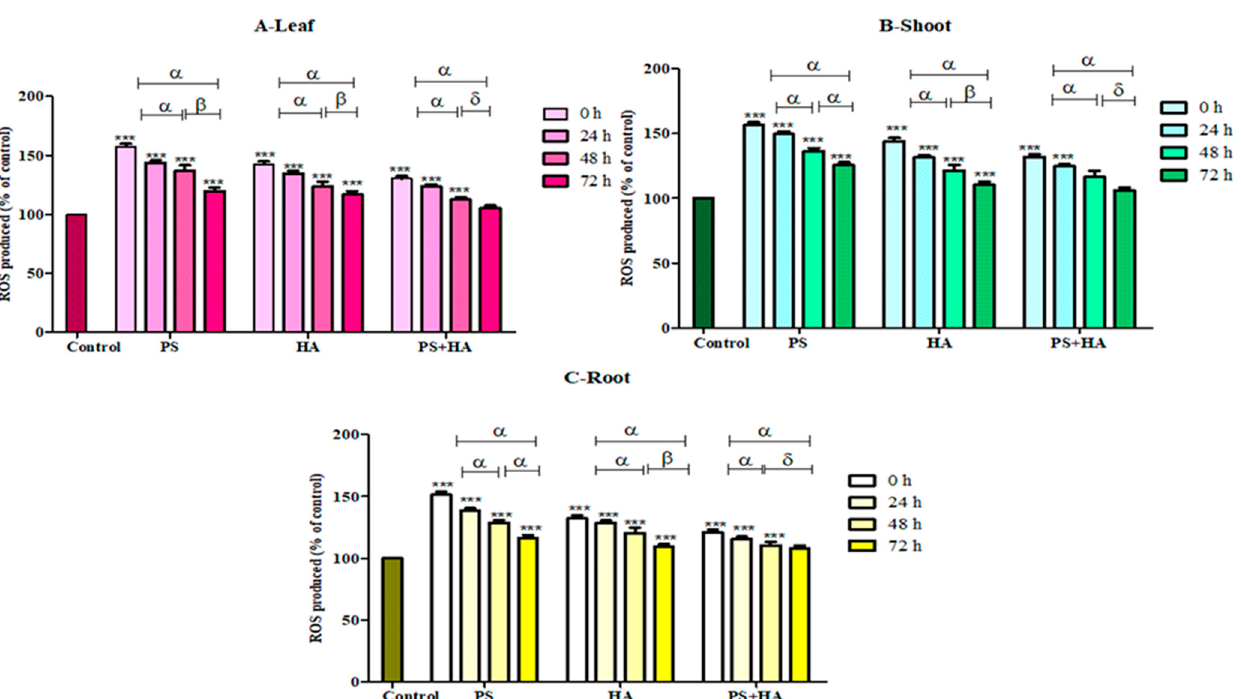
Figure 10. Intracellular Reactive Oxygen Species (ROS) values of PS, HA & PS + HA treated Solanum lycopersicum samples. Note: ‘ *** ’ indicates the percentage difference with respect to the control, ‘ α , β , δ ’ indicates a significant difference ( α = p < 0.001, β = p > 0.001, δ = p > 0.05).